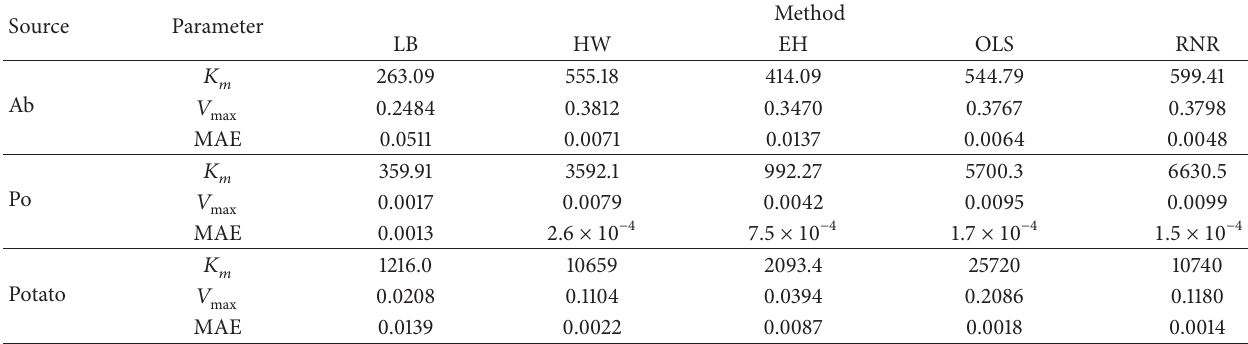
Table 3: Kinetic parameters, 𝐾 𝑚 and 𝑉 max , values, and mean absolute errors for tyrosinase extracted from different sources, estimated using different